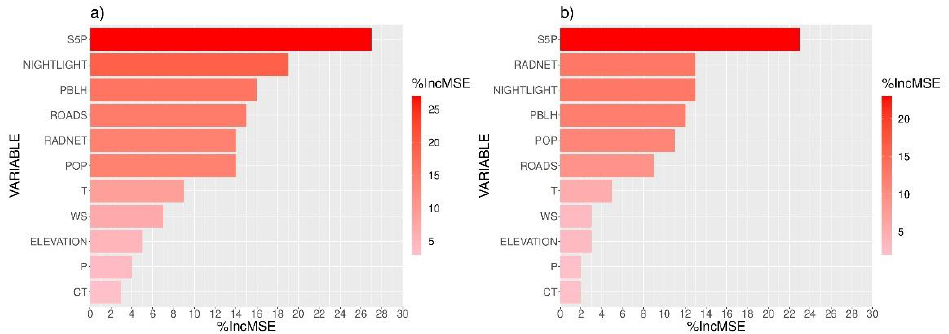
Figure 5. Percentage increases in MSE when excluding variables from the RF model: ( a ) hourly measurements; ( b ) weekly averages. measurements; ( b ) weekly